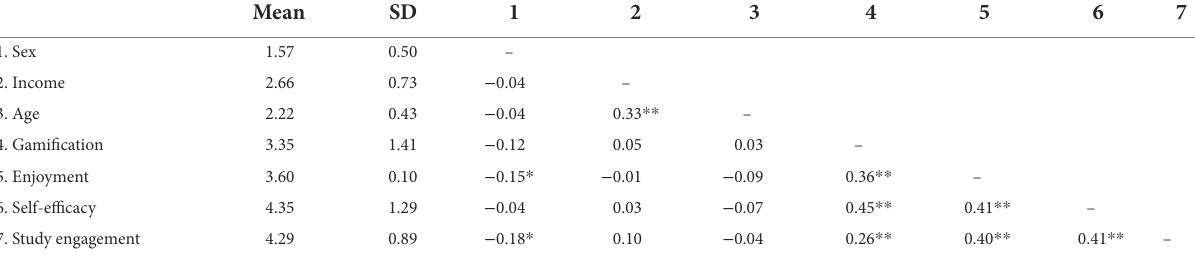
TABLE 2 Descriptive and correlation analysis of study variables.